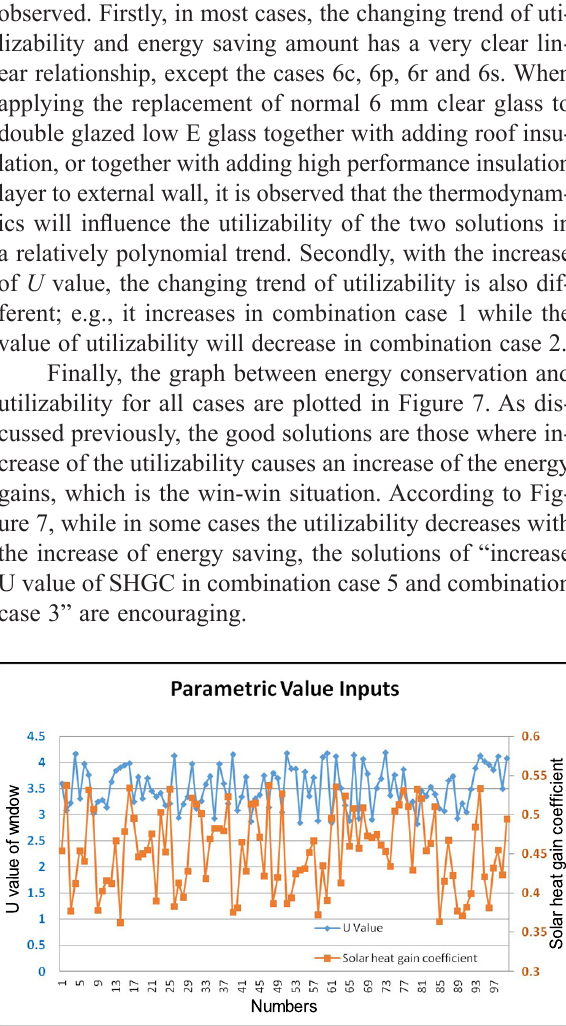
Fig. 5. Parametric value inputs for the sensitivity analysis